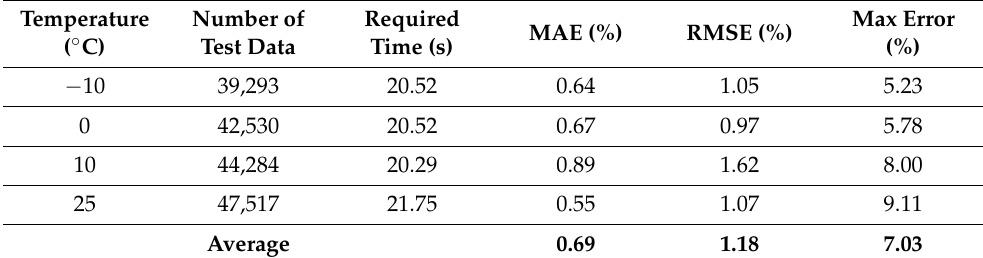
Table 4. Test results of the CNN bi-directional-LSTM